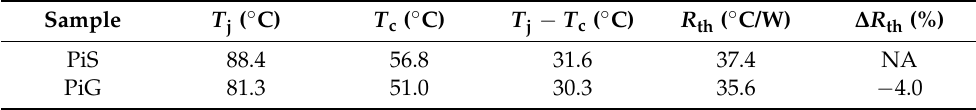
Table 4. Thermal properties of PiS WLED and PiG WLED.